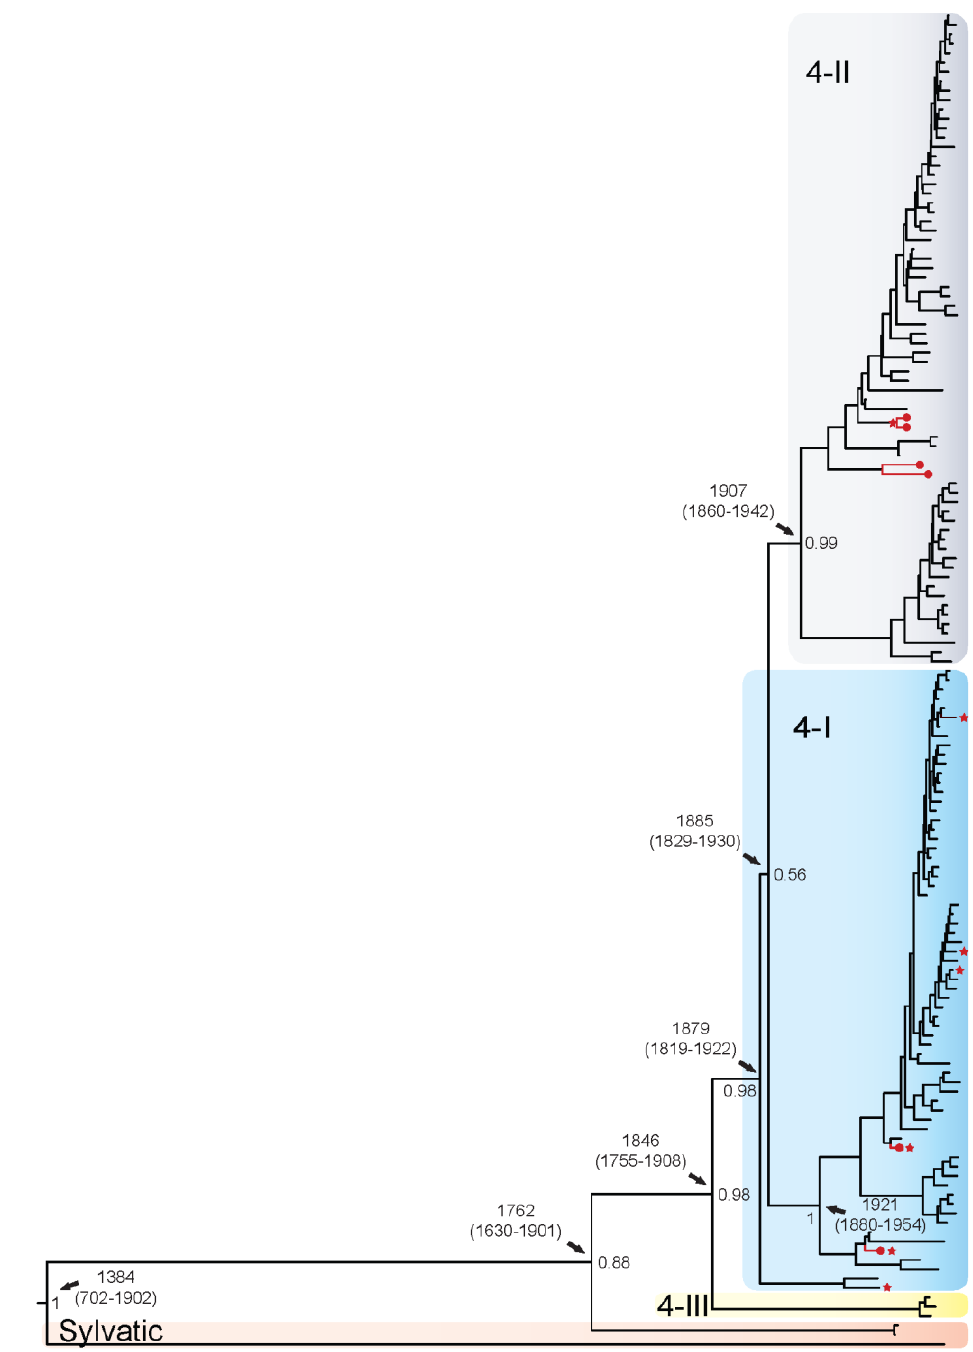
Figure 4. Bayesian phylogenetic tree from analysis of DENV4 whole genome complete coding sequences. Scale axis is representative of calendar years. Posterior node support is indicated for the major branches, with values < 0.8 eliminated in most instances for clarity. Red circles indicate newly sequenced isolates from the QUT Arbovirus collection. Branches under positive selection (see Section 3.2.2) are indicated by red stars.